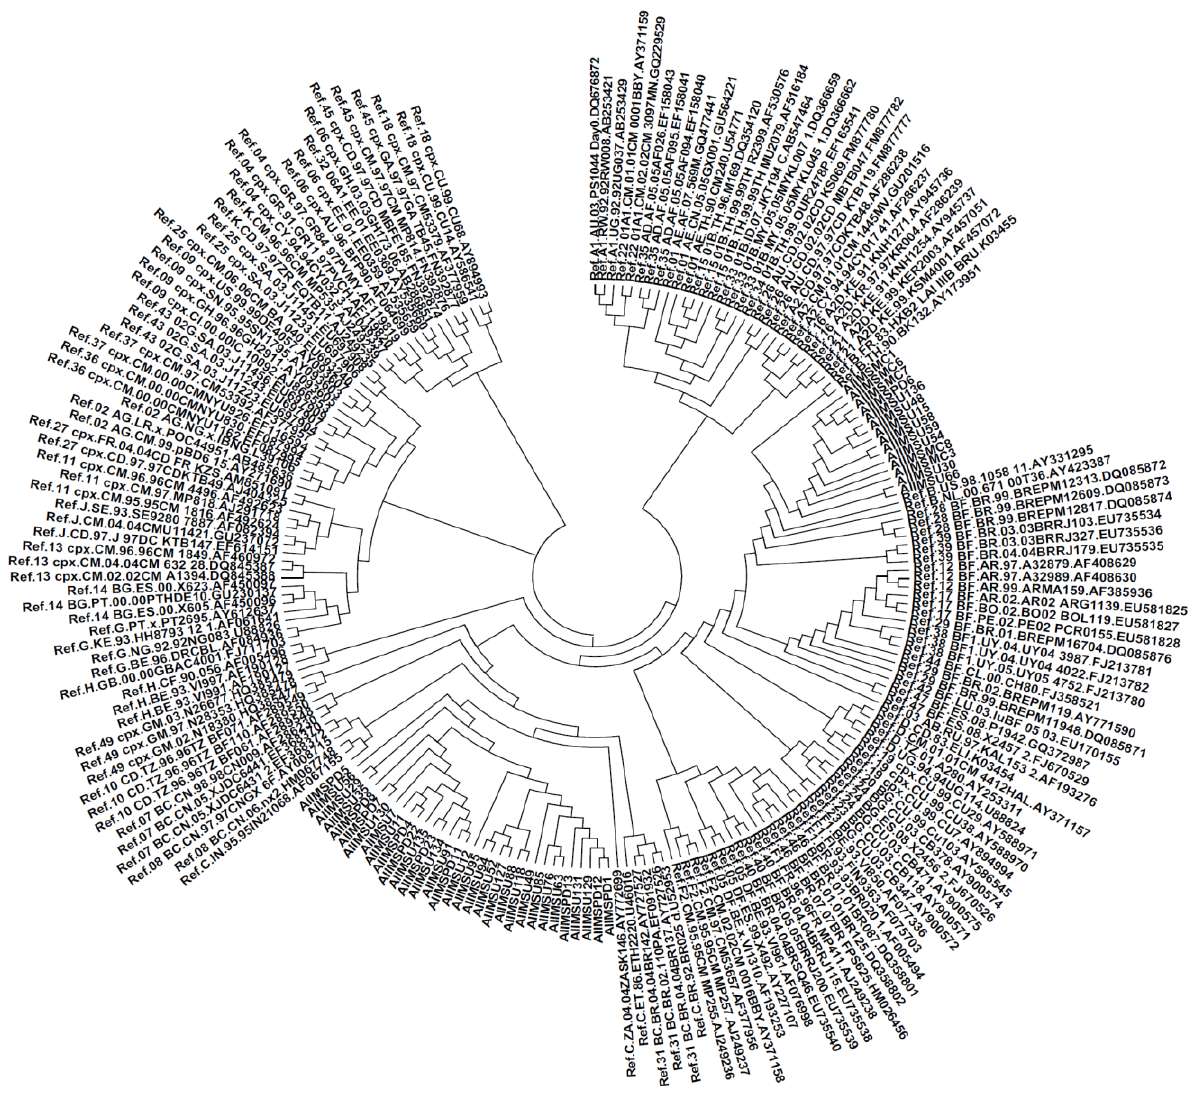
Figure 2. Neighbor-joining phylogenetic tree of Reverse Transcriptase sequences obtained from HIV-1 infected Indian children. A phylogenetic tree was constructed using MEGA 4.0 software using the neighbor joining method with 1000 bootstrap replicates. The sequences obtained from studied patients are labeled as AIIMS. 32 out of 46 RT sequences aligned with clade C while 14 aligned with subtype B